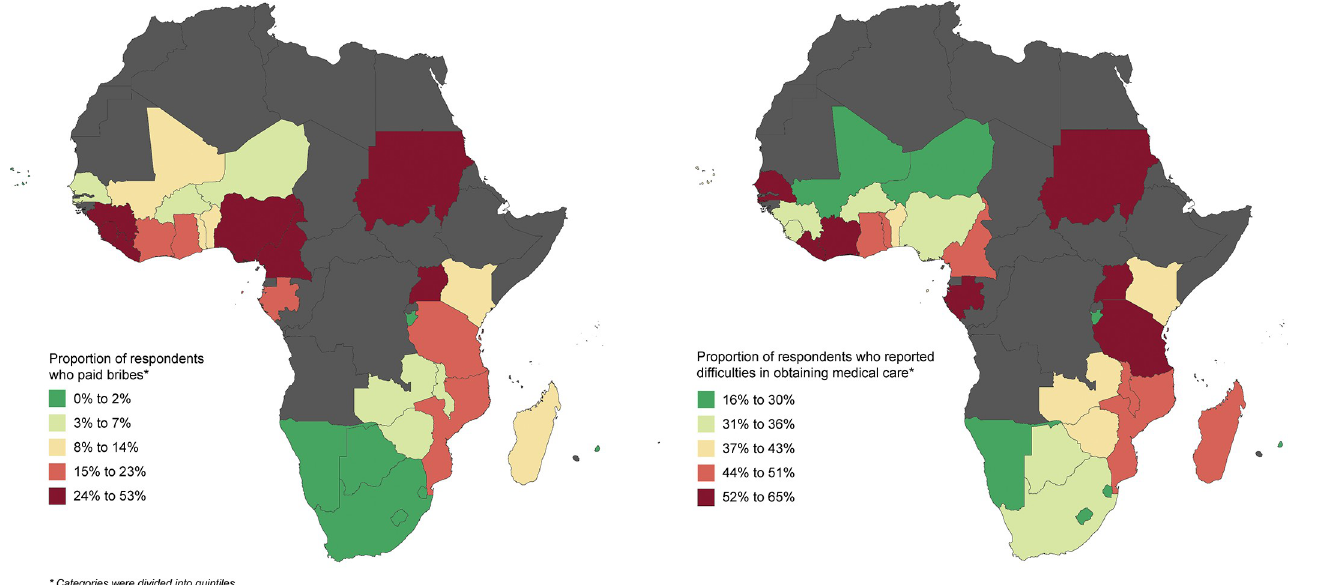
Fig 1. Proportion of respondents who paid bribes versus reported difficulties in obtaining care in sub-Saharan Africa, 2014–2015.